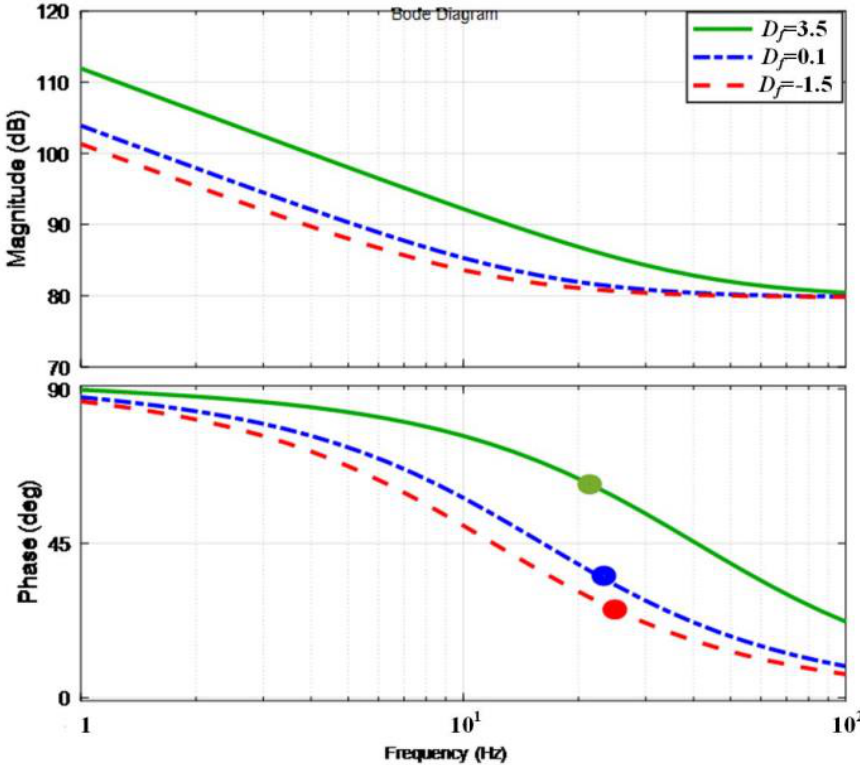
Figure 10. Bode diagram of G 1 ( s ) for different values of D f .